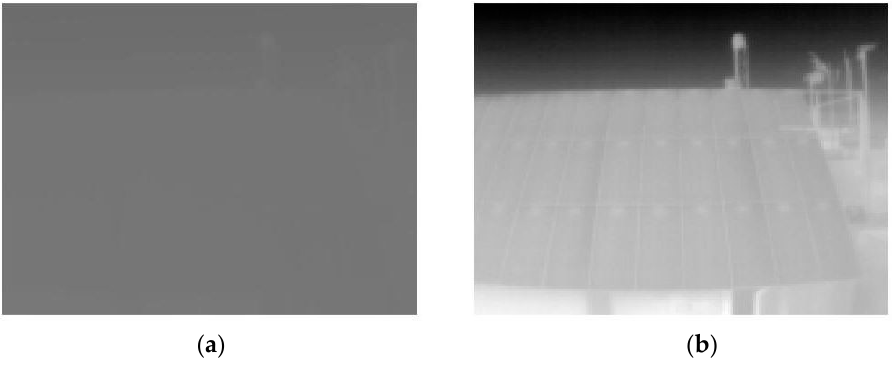
Figure 3. ( a ) Unnormalized RAW image; ( b ) resulting normalized image.